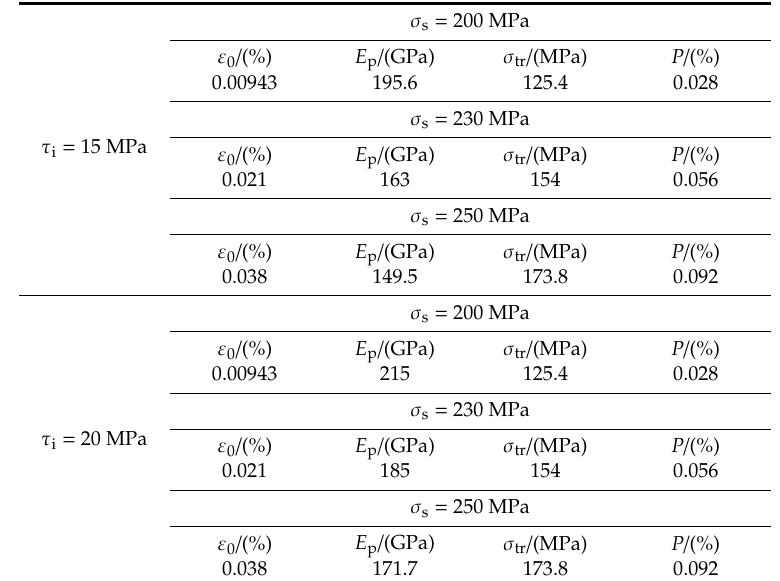
Figure 6. ( a ) The tensile stress–strain curves; ( b ) the tangent modulus versus strain curves; ( c ) the interface debonding fraction versus stress curves; and ( d ) the broken fibers fraction versus stress curves of SiC/SiC composite for conditions without stochastic loading and with stochastic loading of σ s = 200, 230 and 250 MPa when τ i = 20 MPa. Table 2. The effect of interface shear stress ( τ i = 15 and 20 MPa) on tensile stress–strain curve, tangent modulus, interface debonding fraction and broken fiber fraction of SiC/SiC composite subjected to stochastic loading of σ s = 200, 230 and 250 MPa.